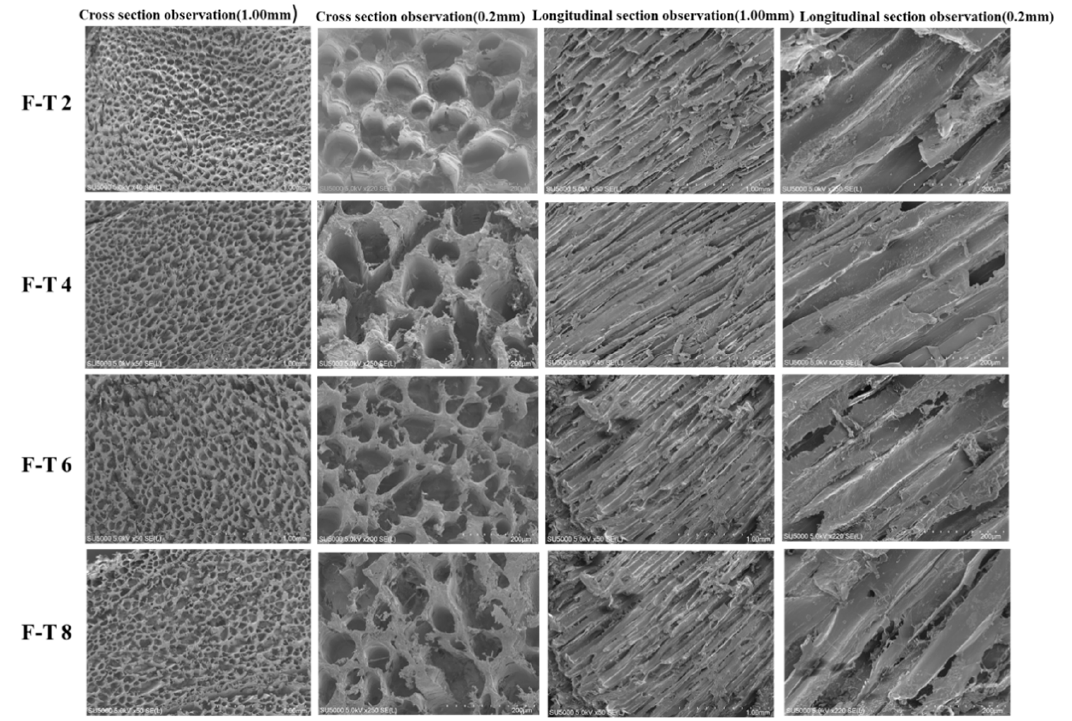
Figure 4. Changes in sample microstructure in various freezing – thawing (F – T) cycles via SEM